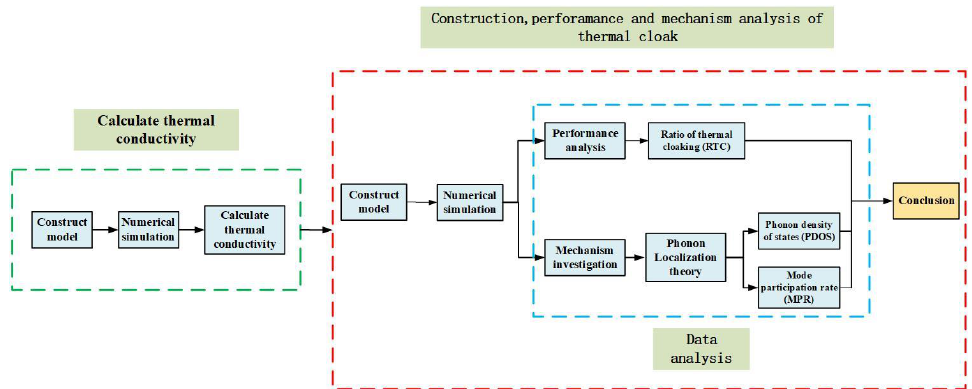
Figure 1. The detailed calculation process of this paper.